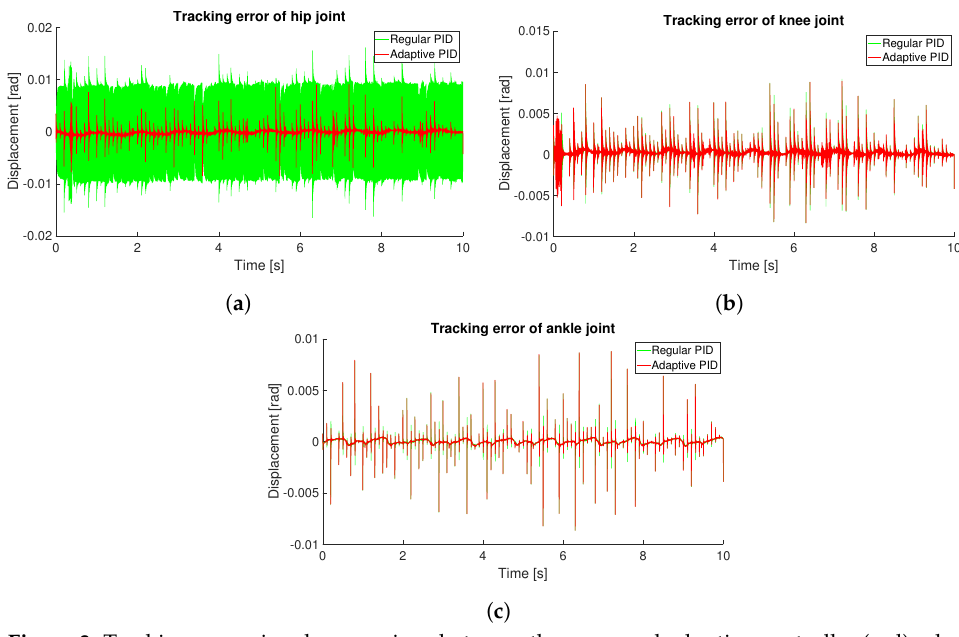
Figure 3. Tracking error signal comparison between the proposed adaptive controller (red) scheme and the regular PID controller (green) for the hip ( a ), knee ( b ) and ankle ( c ).